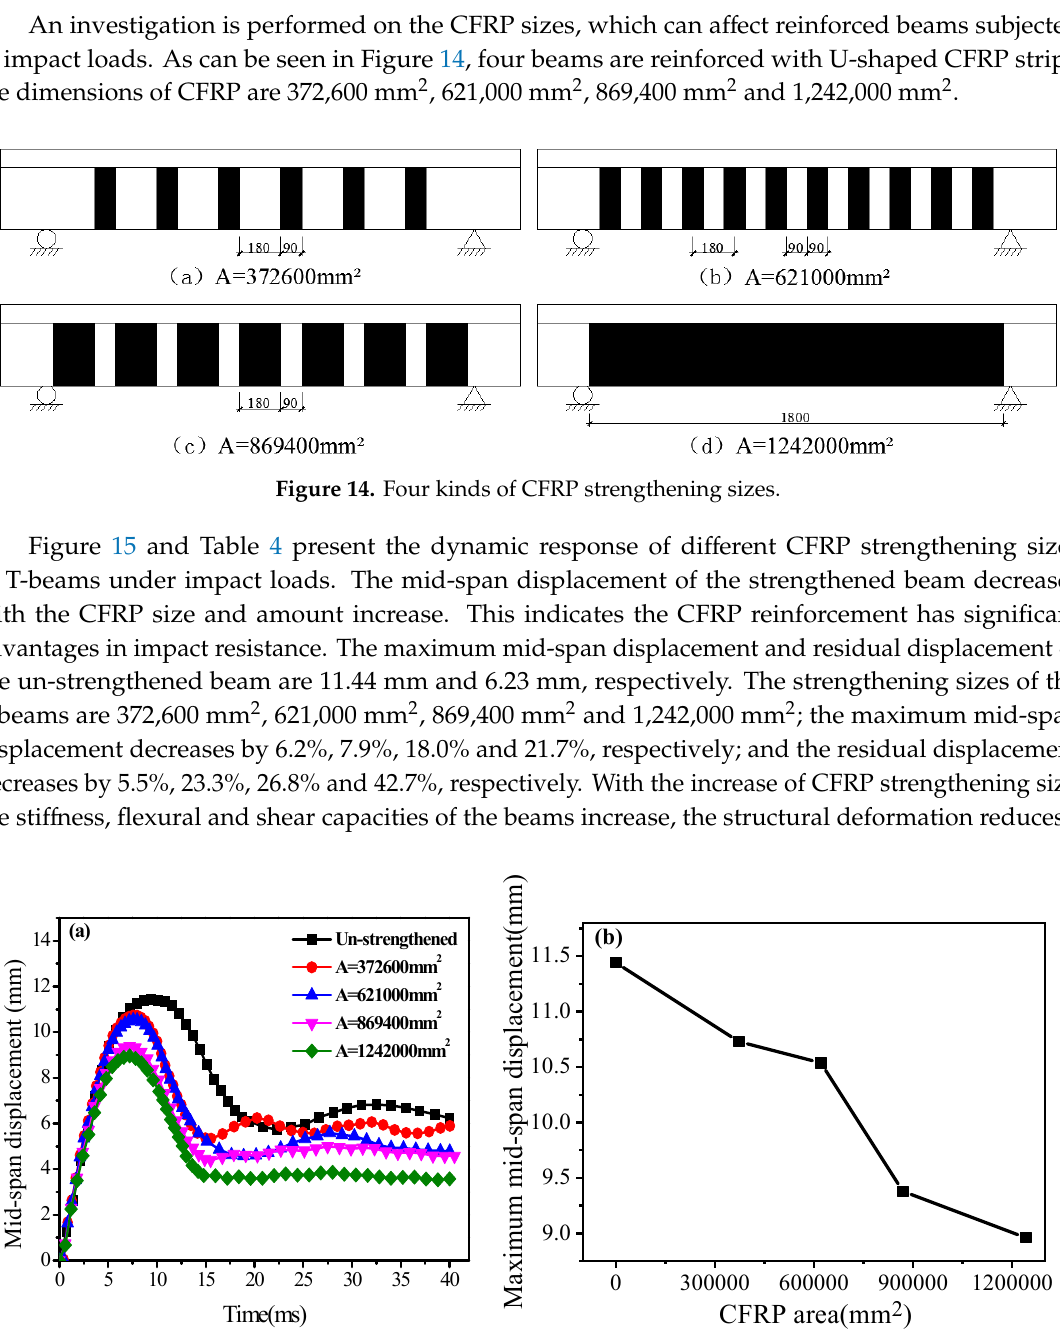
Figure 15. ( a ) Mid-span displacement-time histories and ( b ) maximum displacements of T-beams strengthened with different CFRP strengthening sizes.